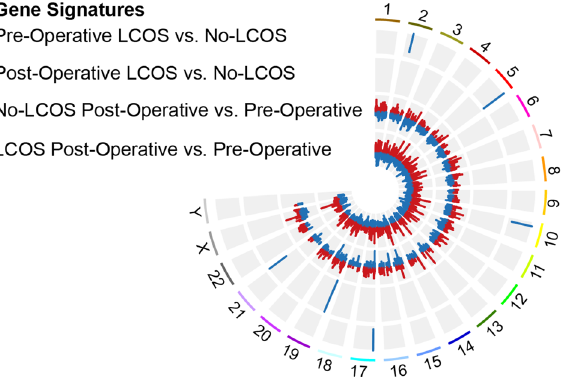
Figure 2. Distribution of differentially regulated genes across the human genome for each comparison performed on the HLHS cohort. The outermost circle represents minimally differential gene regulation in pre-operative samples for patients with and without low cardiac output syndrome (LCOS). The second inner circle compares the differentially regulated genes in post-operative samples of patients with and without LCOS, again showing minimal differential in gene regulation. The third inner circle represents gene expression between pre-operative and post-operative samples in patients who did not develop LCOS, and shows a robust signature. The innermost circle represents the most abundant differential expression, both in terms of number of genes and absolute fold changes, when comparing post-operative samples over pre-operative samples in patients who developed LCOS. Red color indicates increased expression and the blue color indicates decreased expression for the respective comparison. (GraphPad Prism version 8 https ://www.graph pad.com/scien tific -softw are/prism